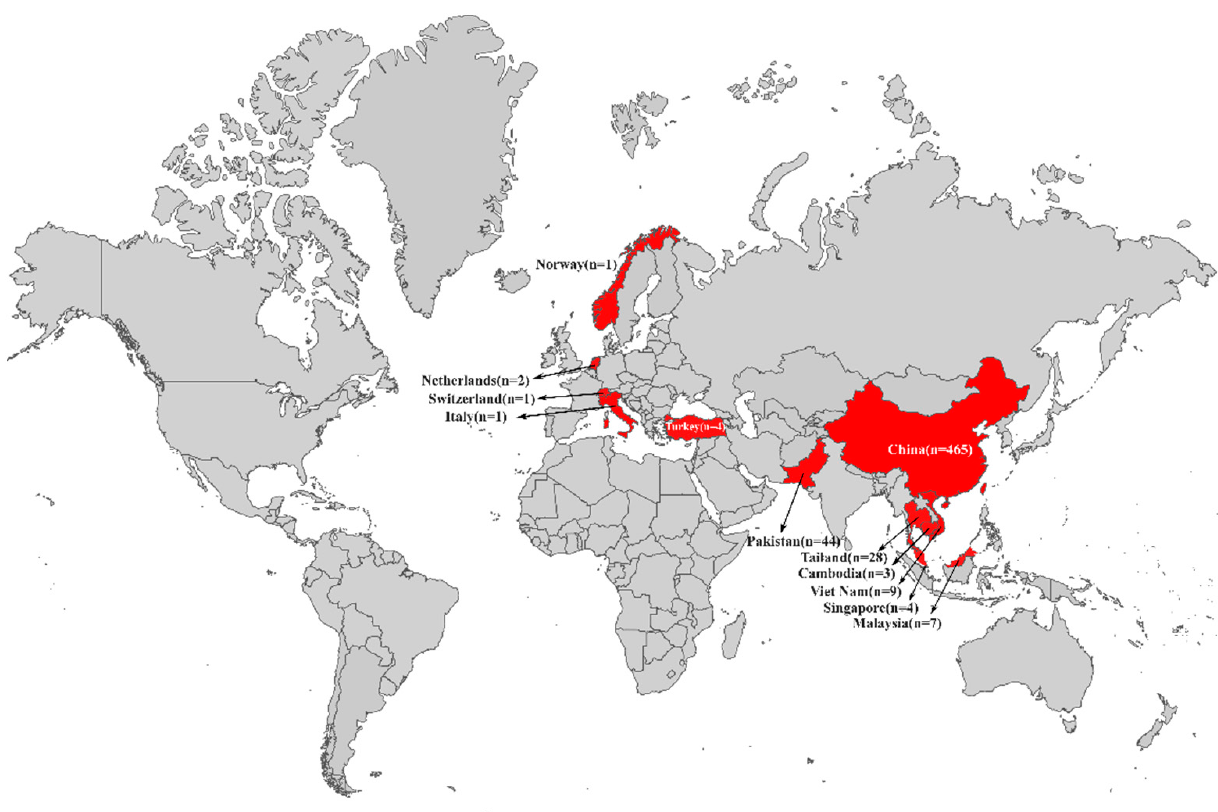
Figure 1. Global distribution of tet (X4)-producing E. coli isolates. 3.2. Pig and Its Products Were the Main Vehicles of tet(X4)-Producing E.